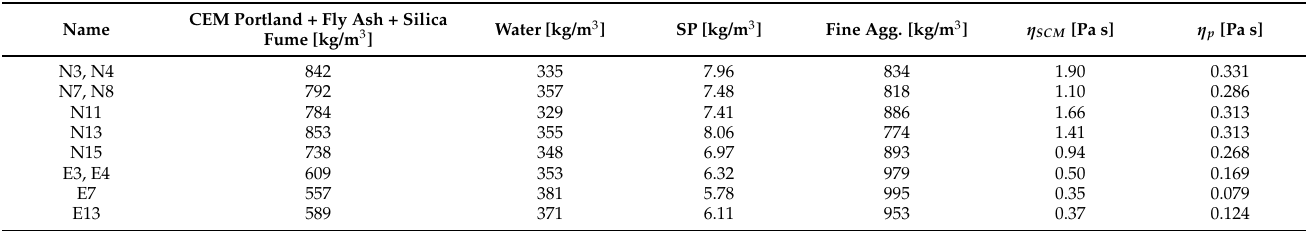
Table A2. Dosages and dynamic viscosities of the self-compacting mortars in Ouro et al.